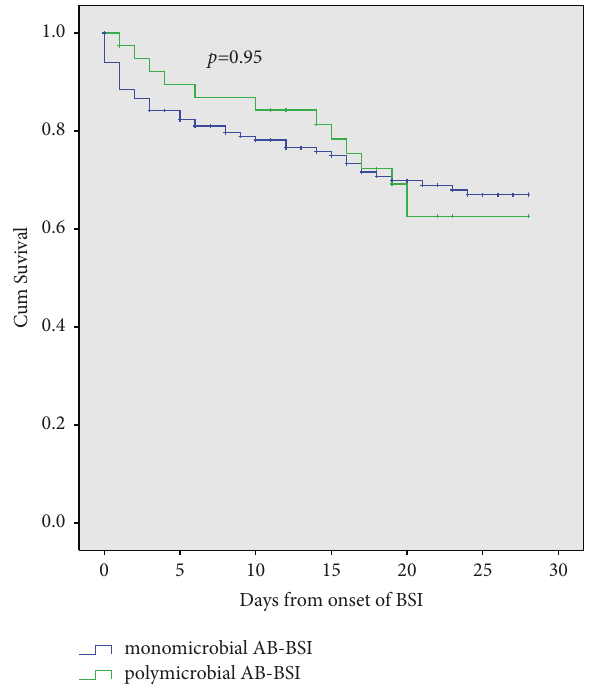
Figure 3: Kaplan–Meier estimates of survival in patients with polymicrobial Acinetobacter baumannii bloodstream infections and monomicrobial Acinetobacter baumannii bloodstream infec- tions. Abbreviations: AB-BSI: Acinetobacter baumannii blood- stream